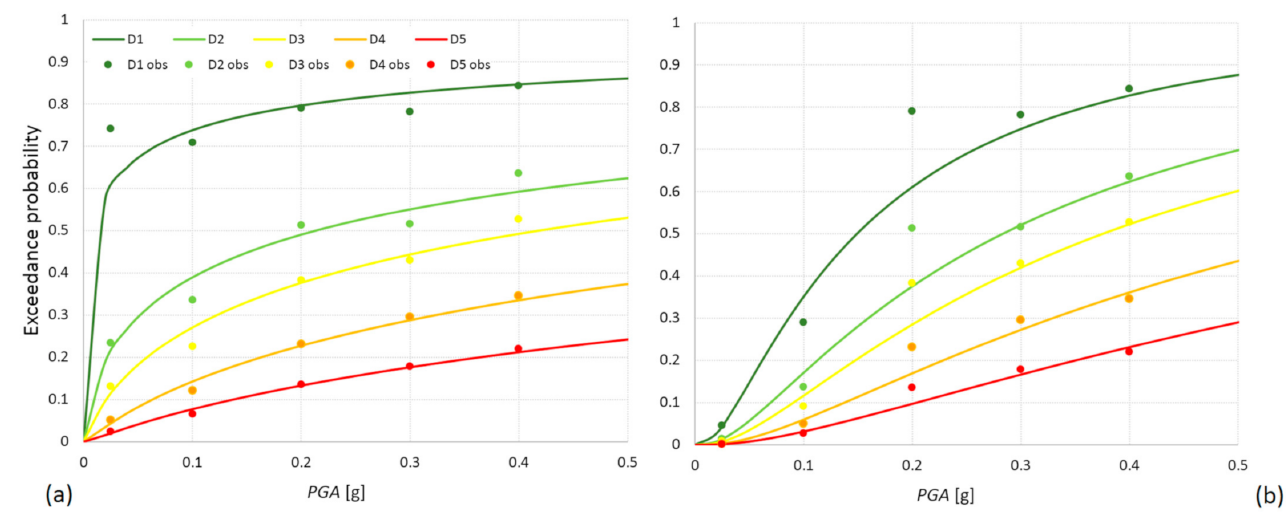
Figure 3. Damage fragility curves for typological class T1R1: discrete observed data and continuous fragility functions; ( a ) not accounting and ( b ) accounting for uninspected buildings.